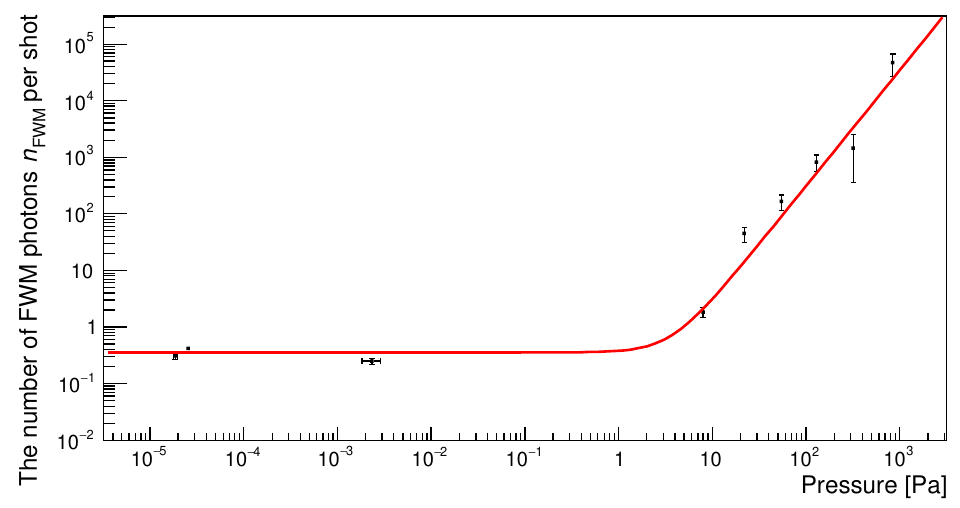
Figure 8 . Pressure dependence of the number of observed FWM photons n FWM per shot within the time window for expected signal arrival. The number of observed FWM photons follows the square of the pressure when the chamber is above 10 Pa . This means that residual-gas-originating FWM backgrounds are dominant in high pressure environments. Below 1 Pa , a nonzero constant component was observed for the first